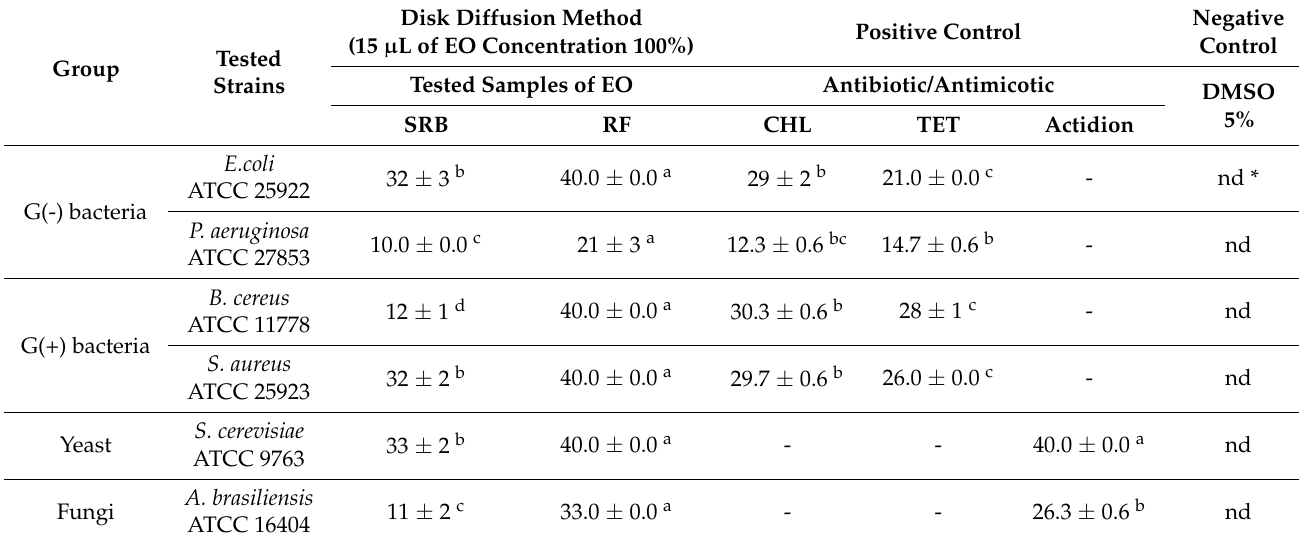
Table 3. Antimicrobial activity of R. officinalis EO from Serbia (SRB) and Russia (RF) (mean value diameter of the inhibition zone (mm) including disc (6 mm)) ± standard deviation).